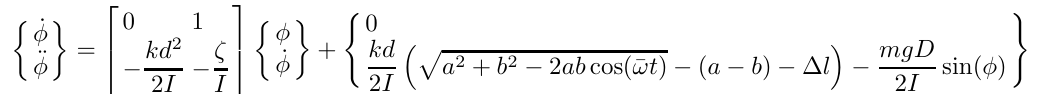
Fig. 3. Response under control. (a) Temporal alternating of UPOs in Poincar´e section #1. (b) Control